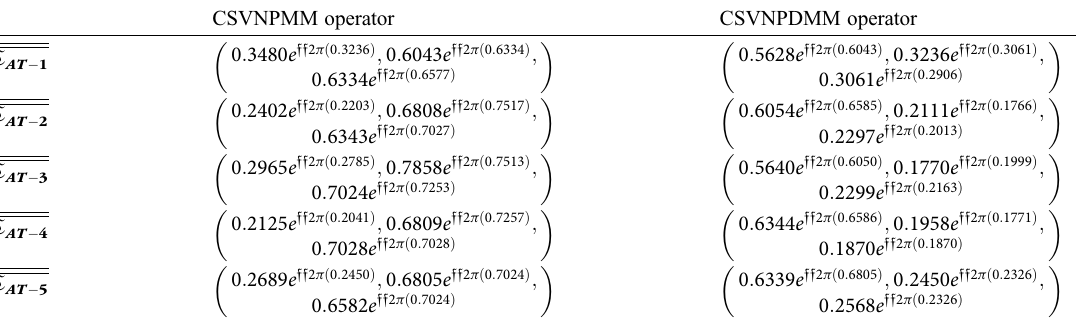
Expression of the aggregated values CSVNPMM operator CSVNPDMM operator